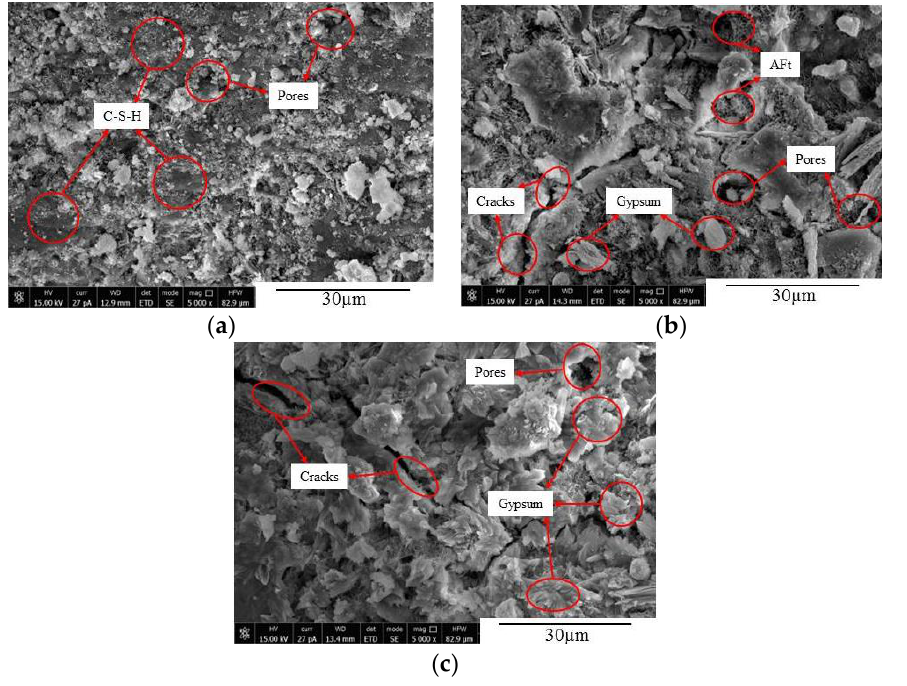
Figure 13. Microcrack expansion of FA10 concrete at different corrosion times. ( a ) FA10-D0; ( b ) FA10-D90; and ( c ) FA10-D150.